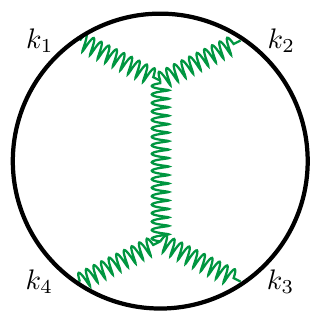
Figure 2 . The four point exchange